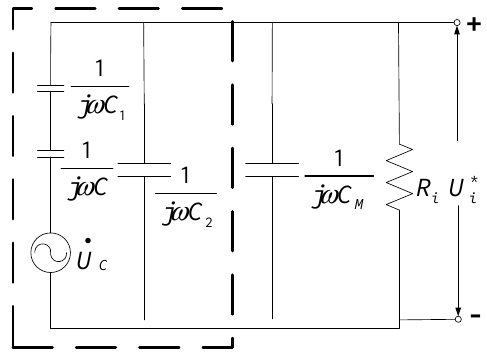
Figure 3. Equivalent circuit of the measuring system in the case of an approaching human body.